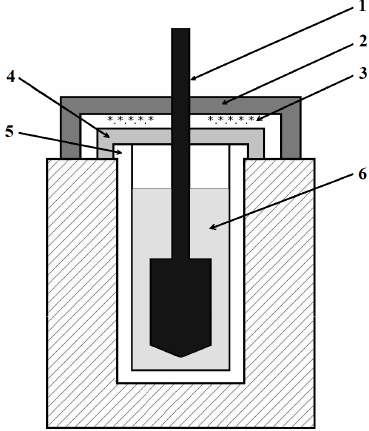
Figure 1: A scheme of the measuring unit with protective cups: 1 – rotor; 2 – plastic cover; 3 – P